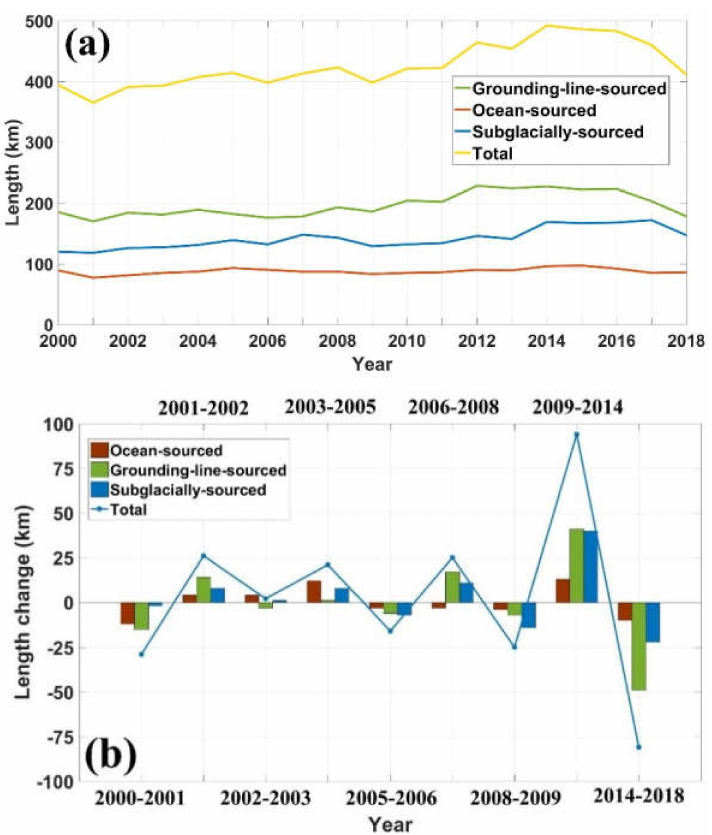
Figure 12. Time series of basal channel length change. ( a ) The interannual variation of the grounding-line- sourced basal channel, ocean-sourced basal channel and subglacially-sourced basal channel. ( b ) Variation trend of three type of basal channel in length: positive value represents length elongation of the basal channel in the corresponding timescale; negative value represents length shortening of the channel in the corresponding